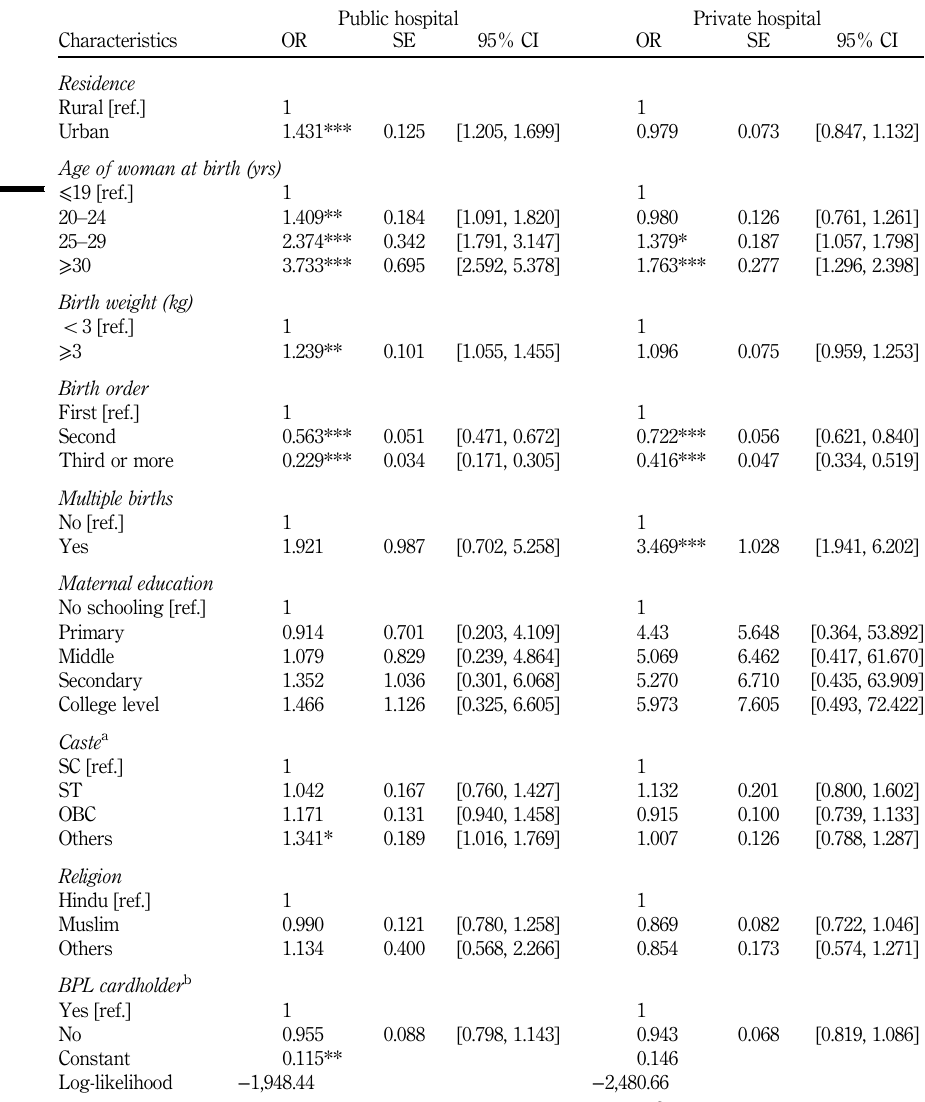
Table V. Logistic regression results; likelihood estimates of caesarean deliveries for “ institutional births